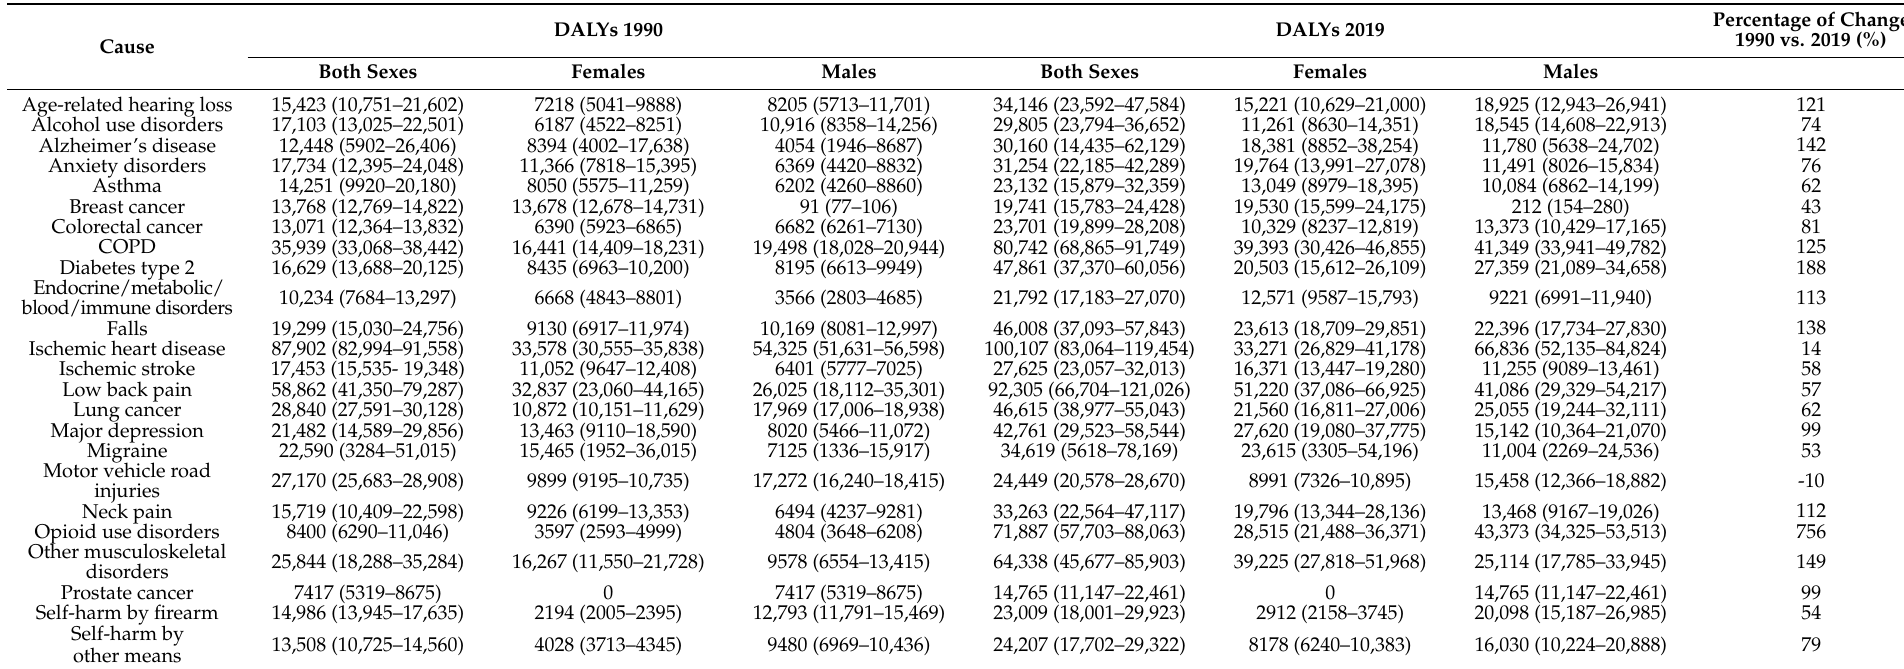
Table 1. Top 24 causes of disability-adjusted life years (DALYs) in both sexes, females and males, all ages, in Colorado, 1990 and